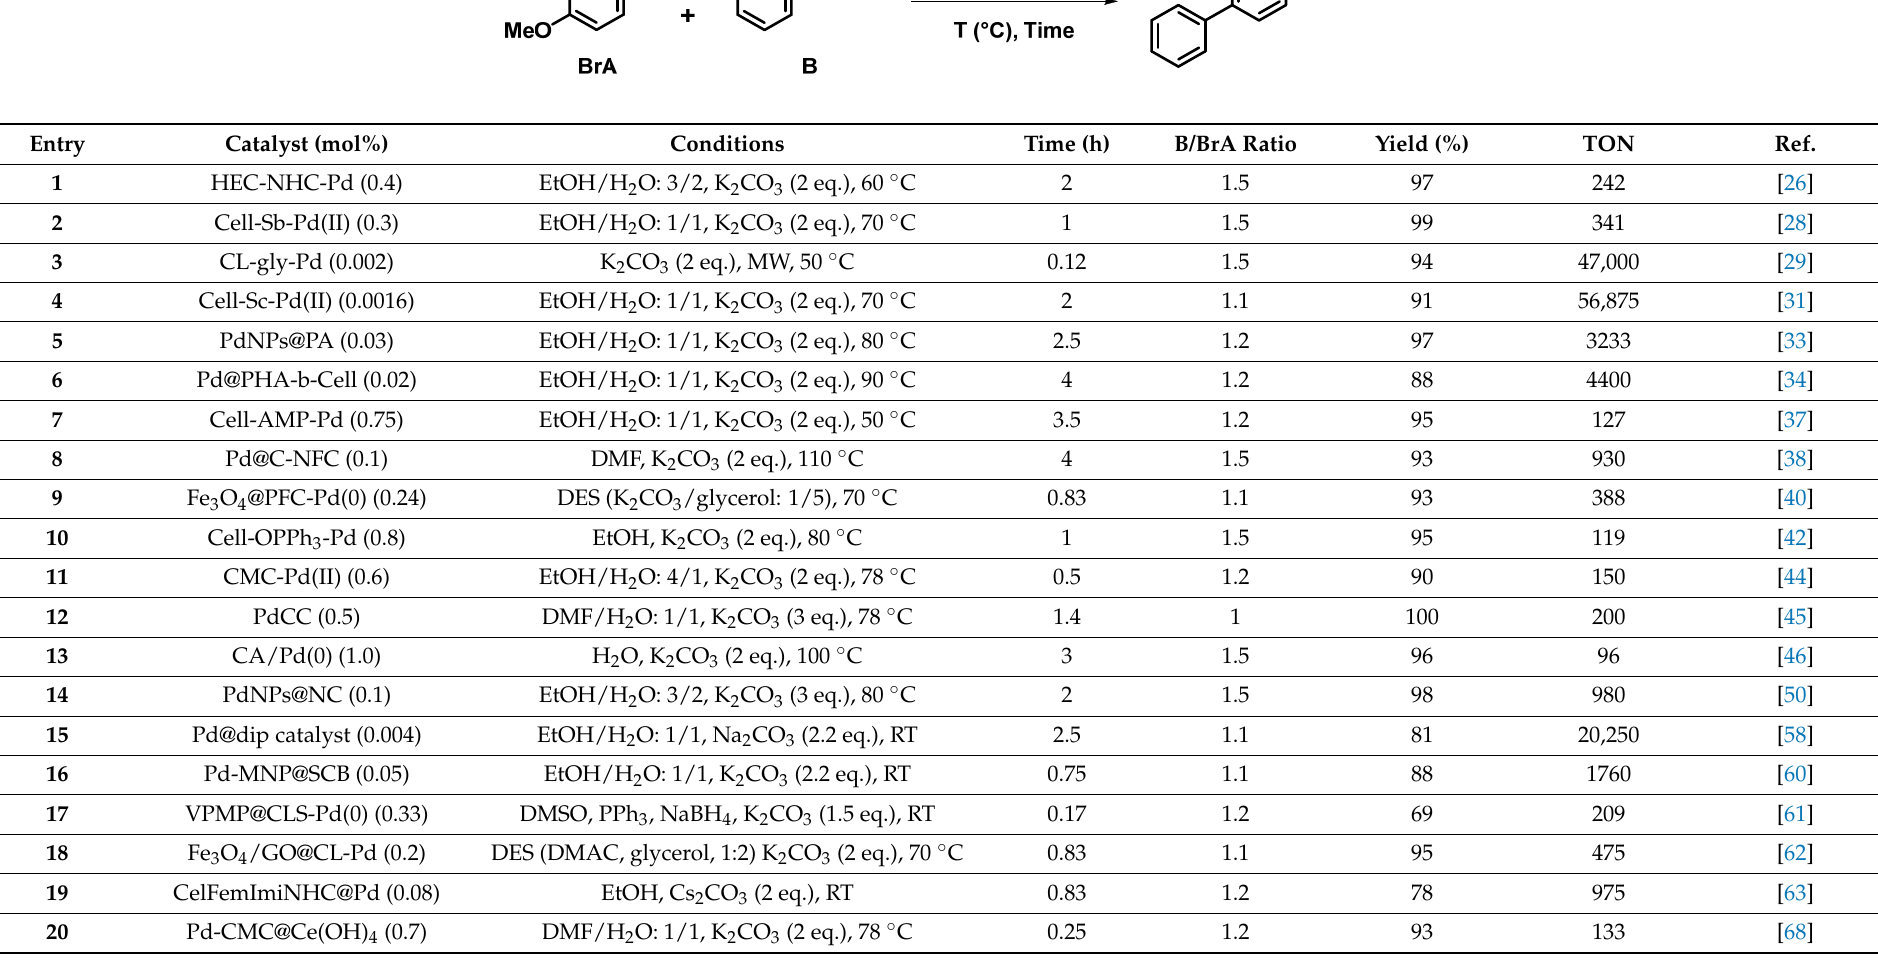
Table 1. Suzuki–Miyaura cross-coupling reaction between 4-methoxyphenyl bromide (BrA) and phenylboronic acid (B). Comparison of the reaction conditions and results from different articles.